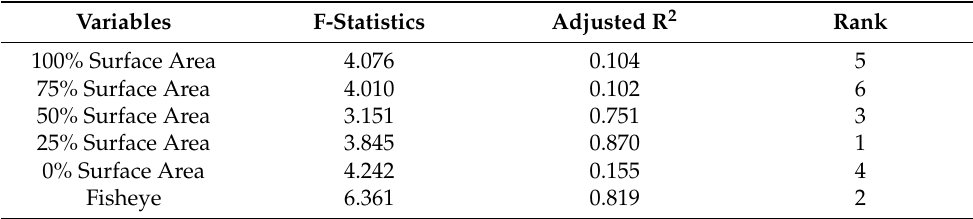
Table 4. Results of regression analysis for the selection of the forest photography method.